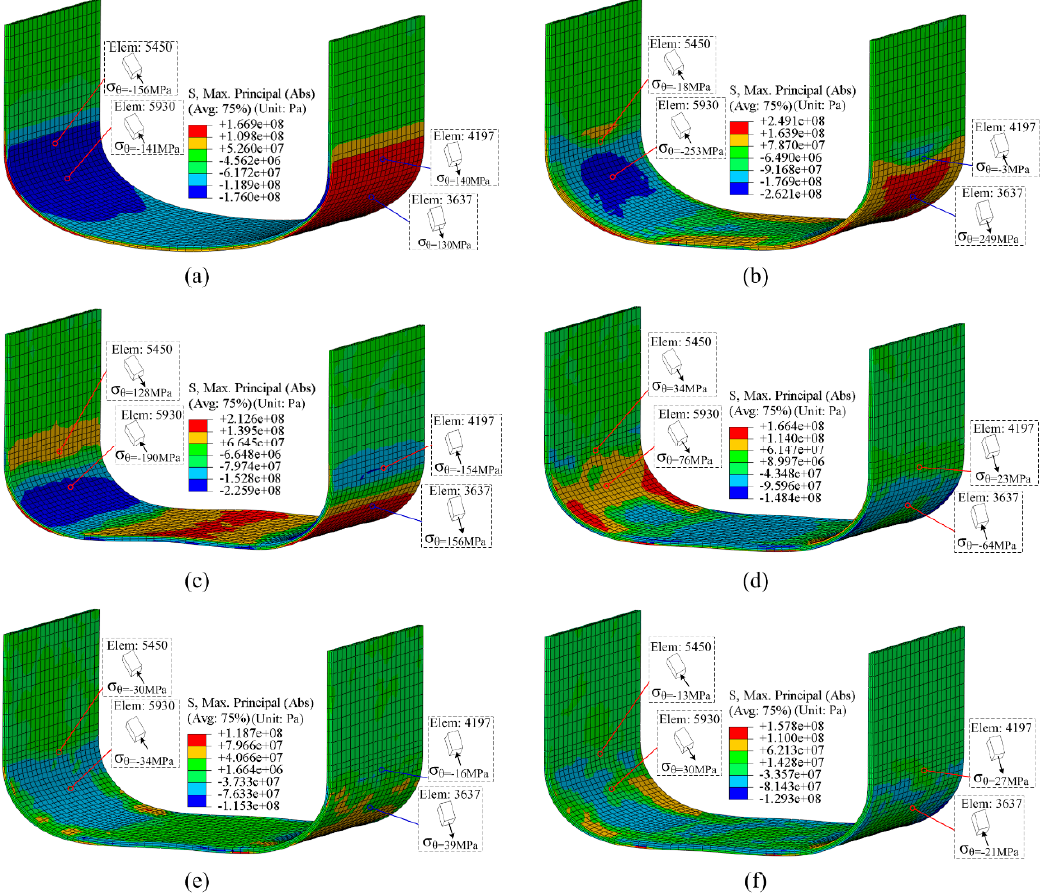
Figure 9. Distribution of tangential stresses in the sheet for 2 kV at different times: ( a ) 0 μ s, ( b ) 75 μ s, ( c ) 300 μ s, ( d ) 600 μ s, ( e ) 1500 μ s, and ( f ) 3000 μ s.